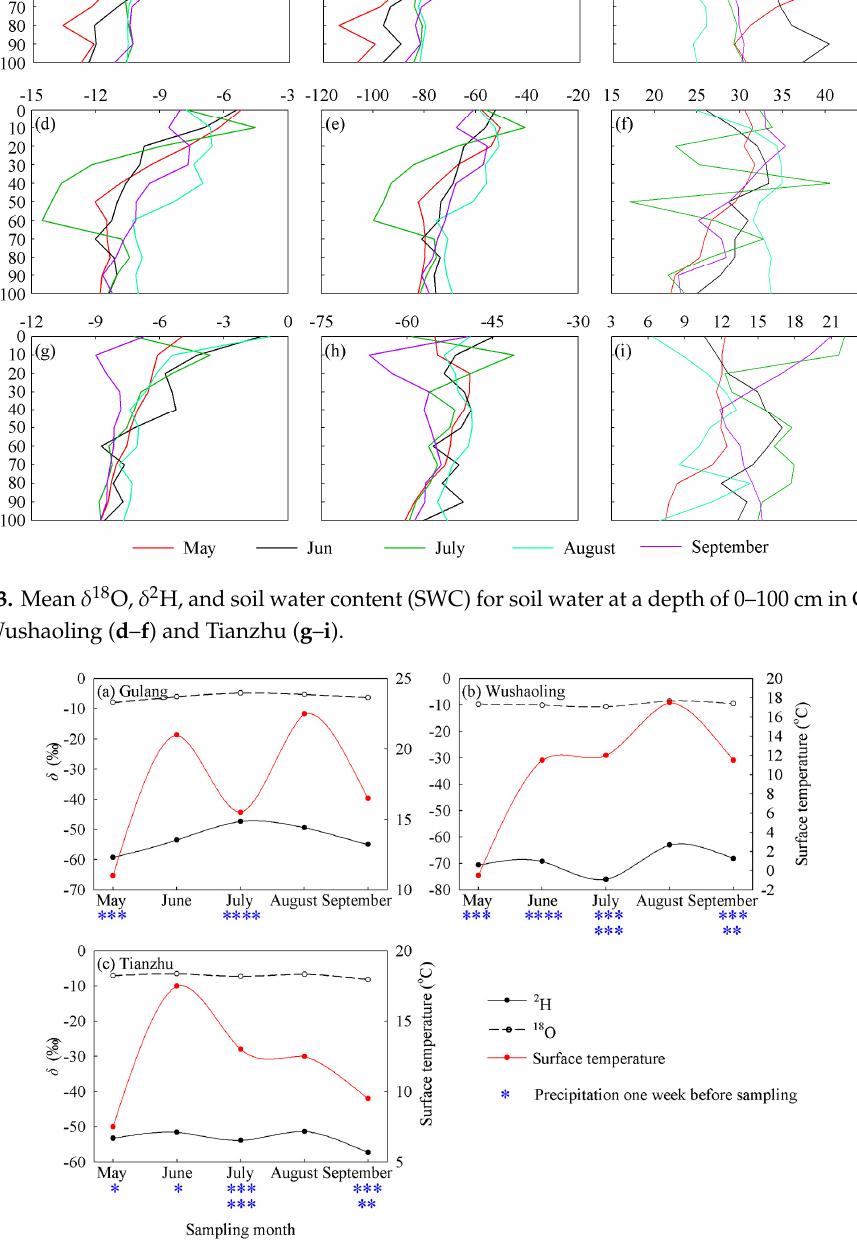
Figure 4. Monthly variation of SWC-weighted soil water δ 18 O and δ 2 H, and near-surface temperature. ( a – c ) are the variations at Gulang, Wushaoling and Tianzhu,